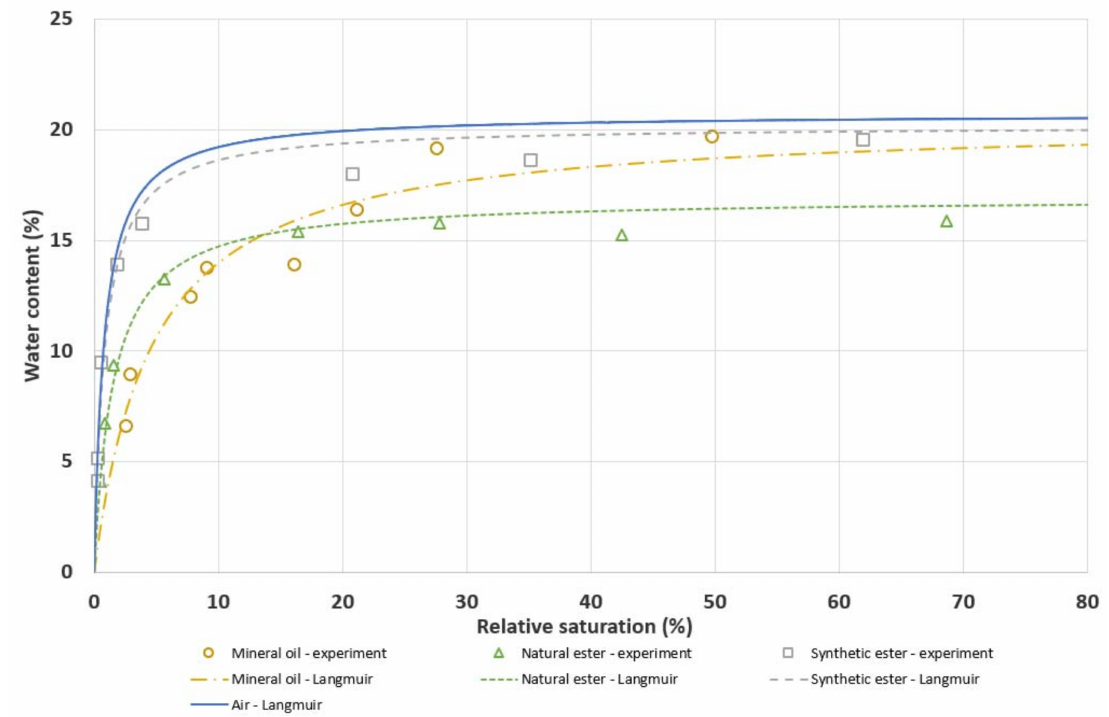
Figure 1. Water sorption isotherms of the 3A molecular sieve in mineral oil, natural ester, synthetic ester, and air, T = 35 ◦